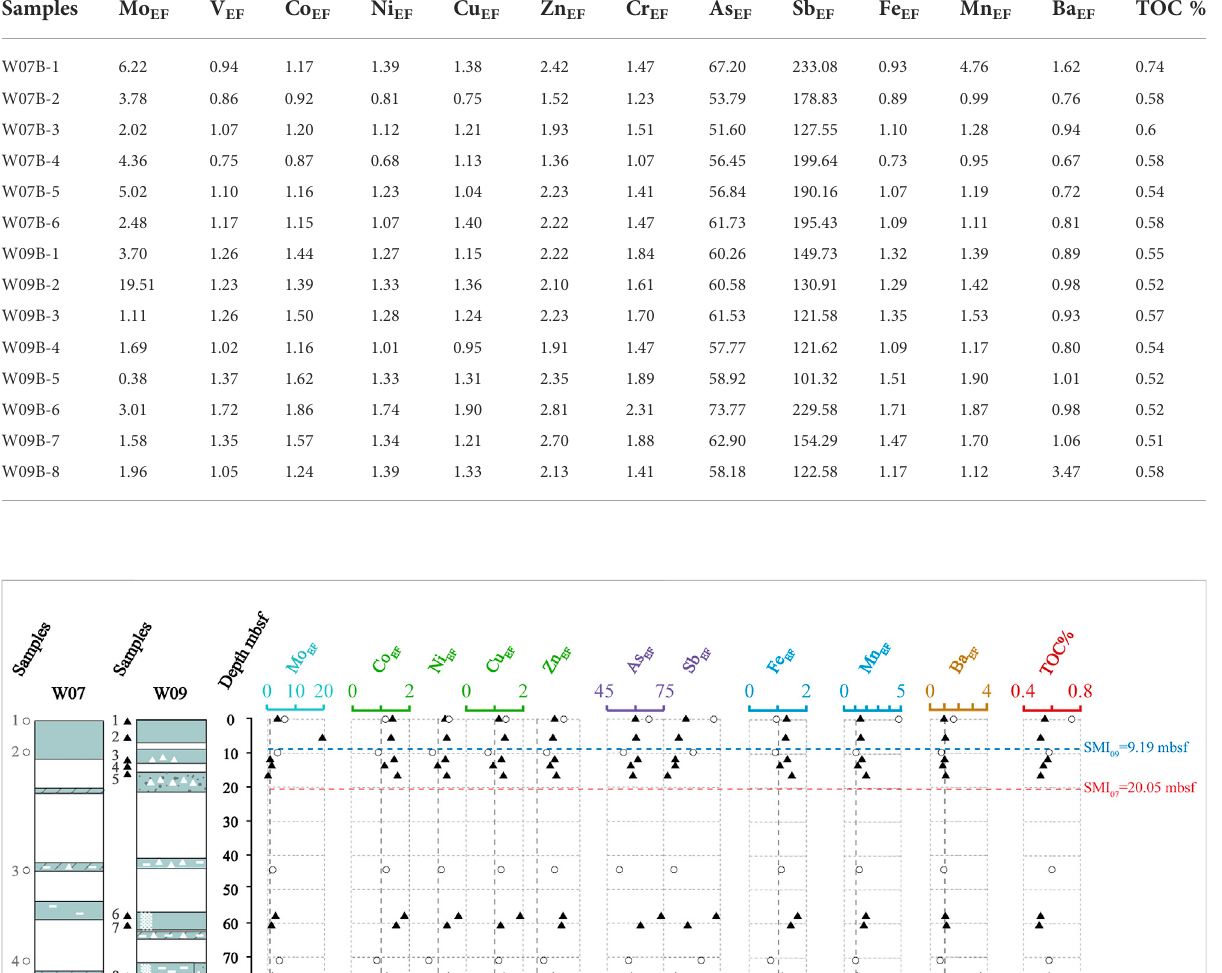
TABLE 3 Enrichment factors for trace elements and TOC% of sediments. Samples